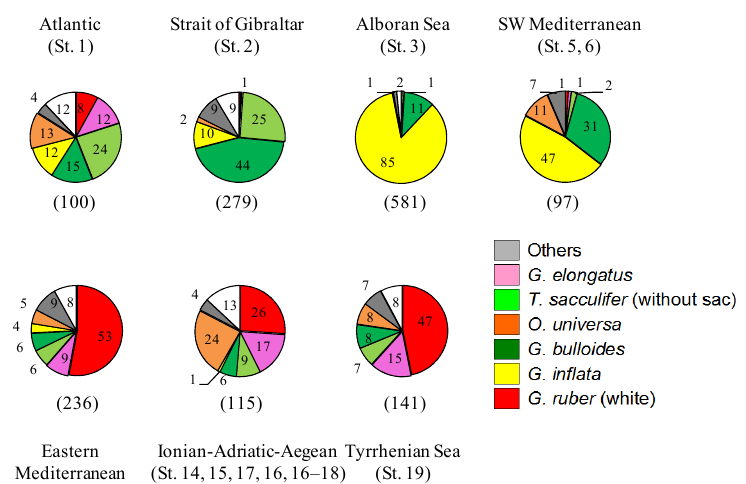
Figure 6. Relative abundance of planktic foraminifera (%). Category “Others” is comprised of G. siphonifera–G. calida–G. radians plexus, T. quadrilobatus , H. pelagica , G. ruber (pink), G. menardii and T. sacculifer (with sac). Less than 1% values are not shown. Number in parentheses indicates the total individuals of each